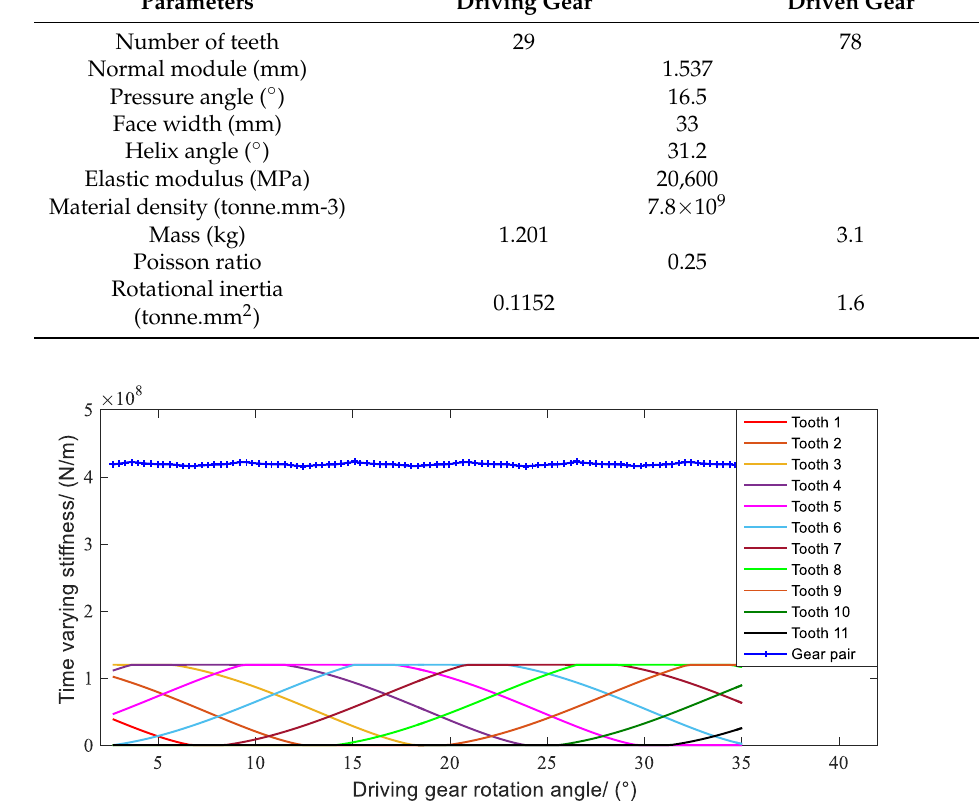
Figure 13. Time varying meshing stiffness of the first gear pair.